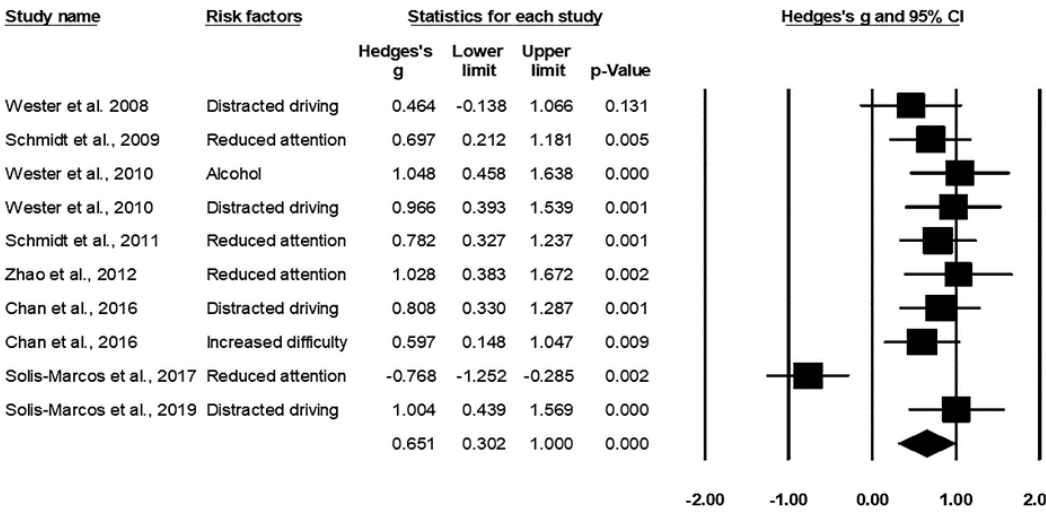
Figure 1. Forest plot for reaction times in relation to the risk factors.